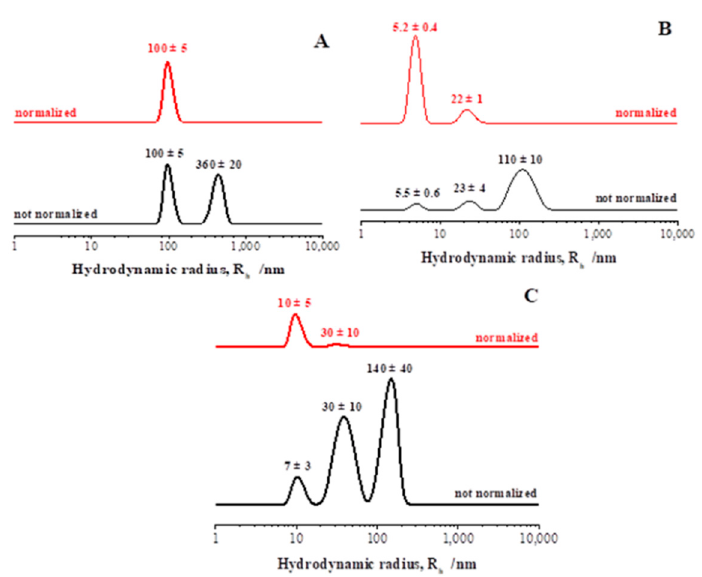
Figure 17. Hydrodynamic radius distributions of SeNPs produced by the 5AG strain in the complex medium A (panel ( A )), the medium with glucose B (panel ( B )), and the minimal medium with molasses C (panel ( C )).